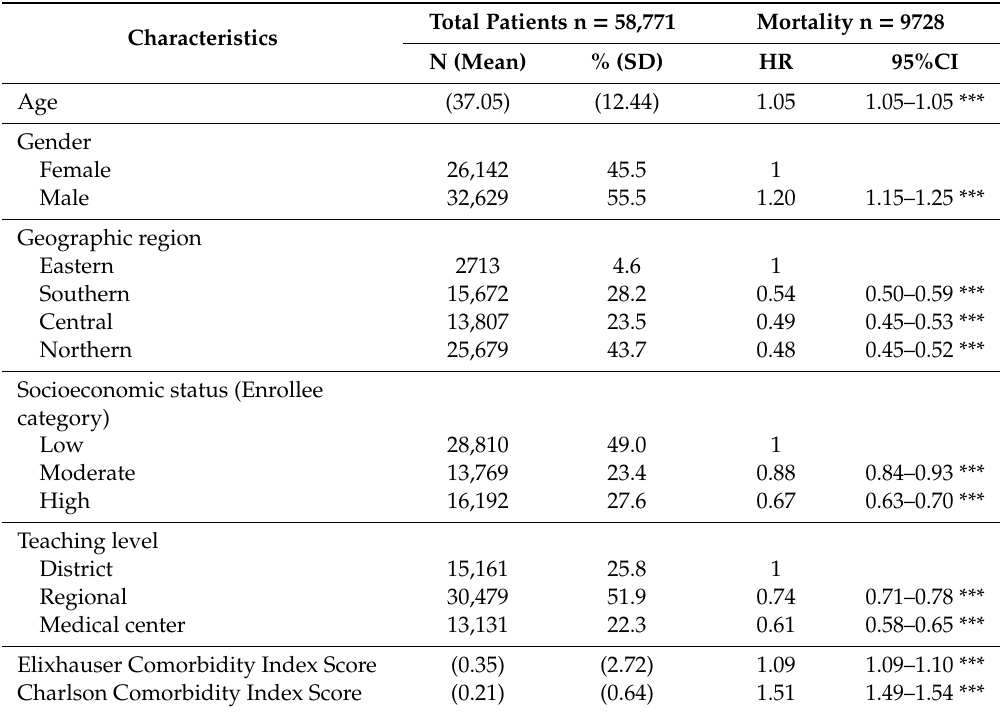
Table 1. Demographic Characteristics and the Hazard Ratio of